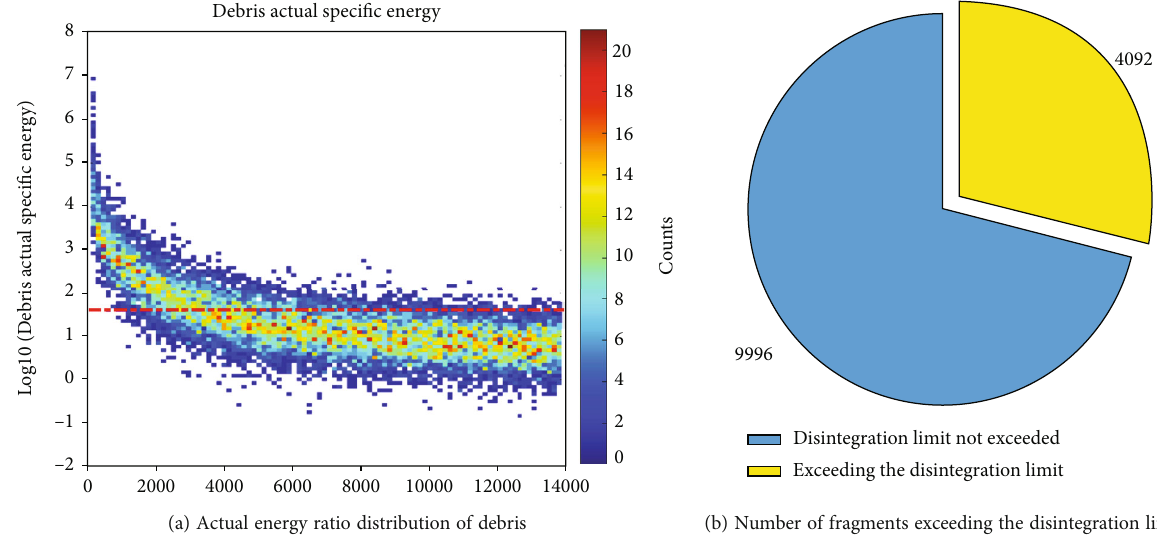
Figure 16: The actual energy ratio of debris.